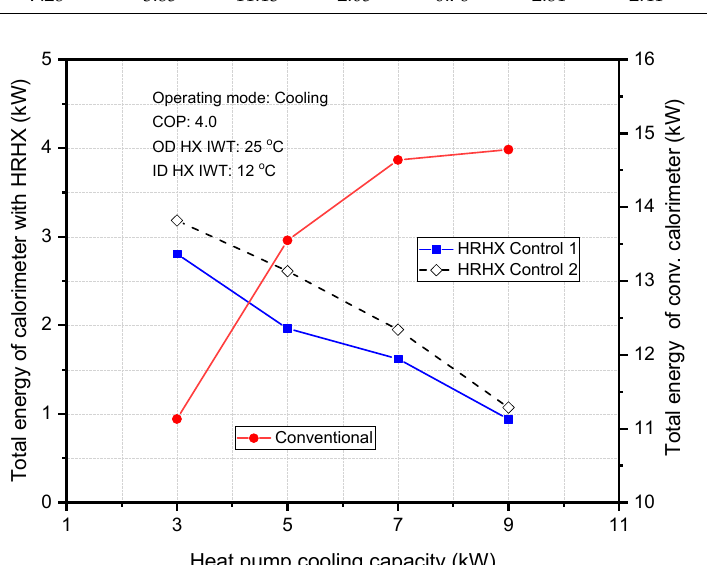
Figure 14. Total energy analysis for a conventional calorimeter and the heat recovery calorimeter in cooling mode.